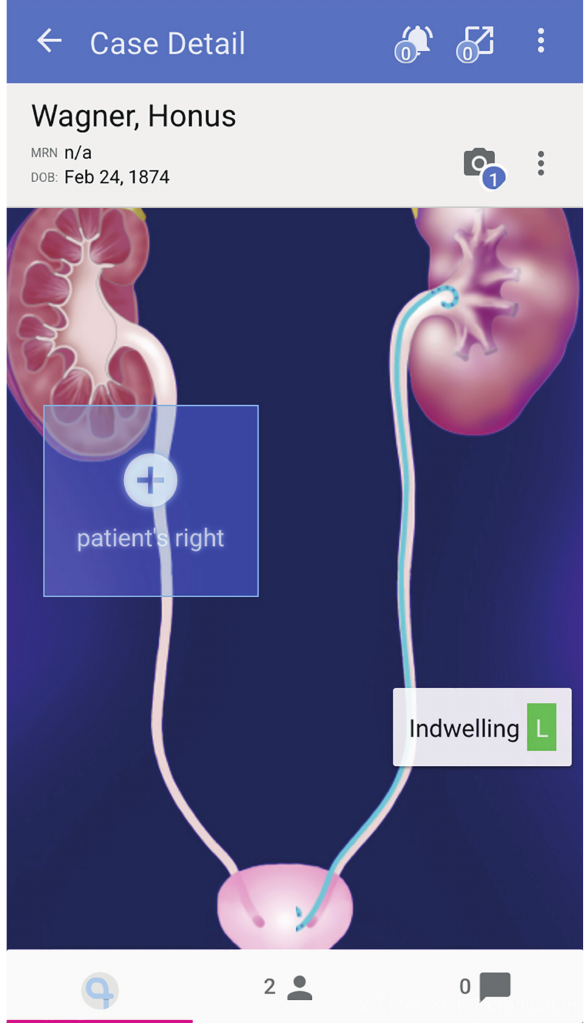
Figure 1 - A view of ureteral stent care plan of patient (Images© Copyright visible Health, Inc. Created for demonstration).